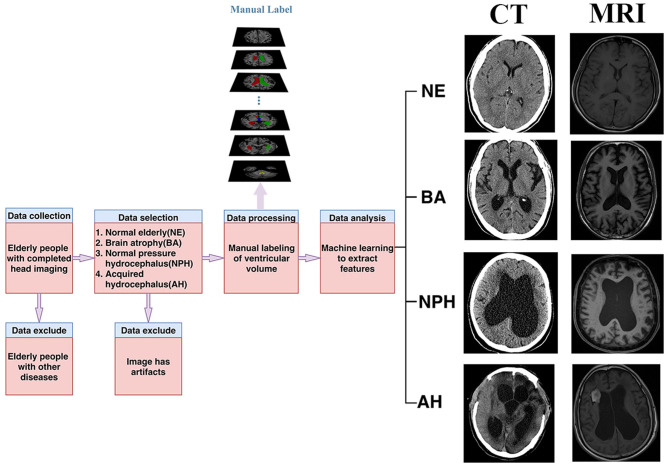
Study flow chart for the inclusion of participants.